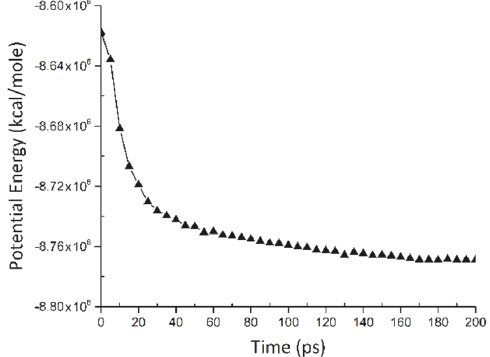
Figure 14. Decrease of potential energy as a function of time for double sphere model.